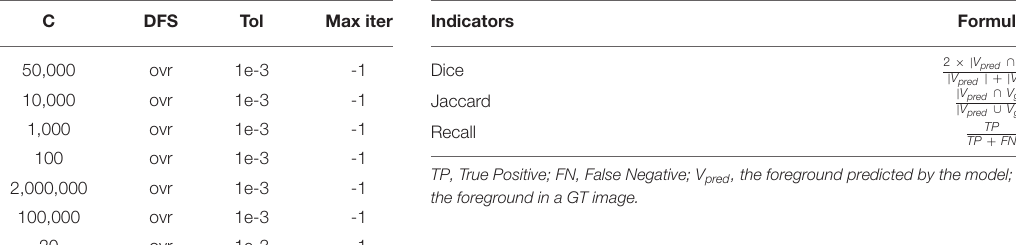
TABLE 4 | Evaluation metrics of segmentation method.